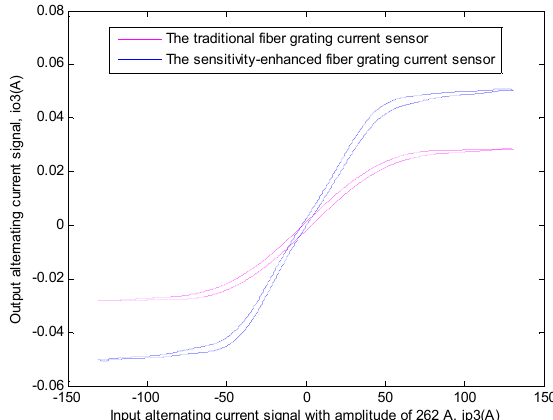
Figure 13. The transfer function relationship curves of the two sensors between output alternating current signal ( i o 3 ) and input alternating current signal with amplitude of 262 A ( i p 3 ) respectively. The blue curve shows the transfer function relationship of the sensitivity-enhanced fiber grating current sensor. The magenta curve shows the transfer function relationship of the traditional fiber grating current sensor.